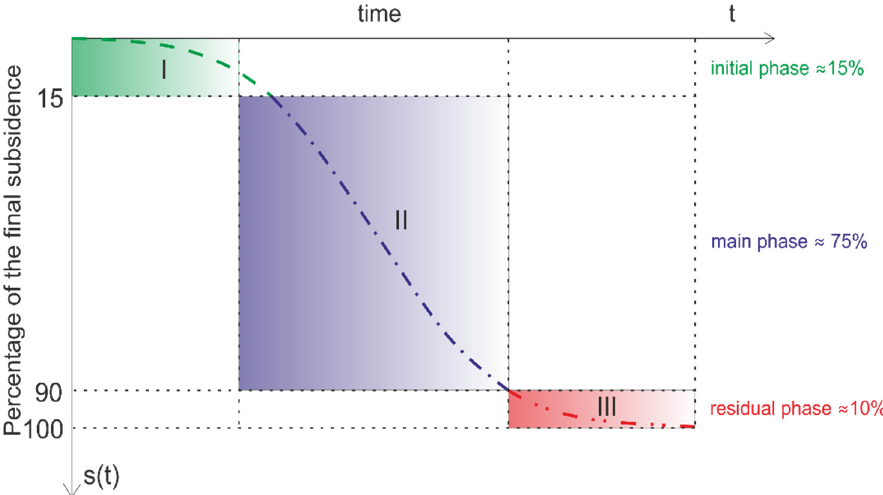
Figure 1. Sketch map of subsidence development for a surface point.